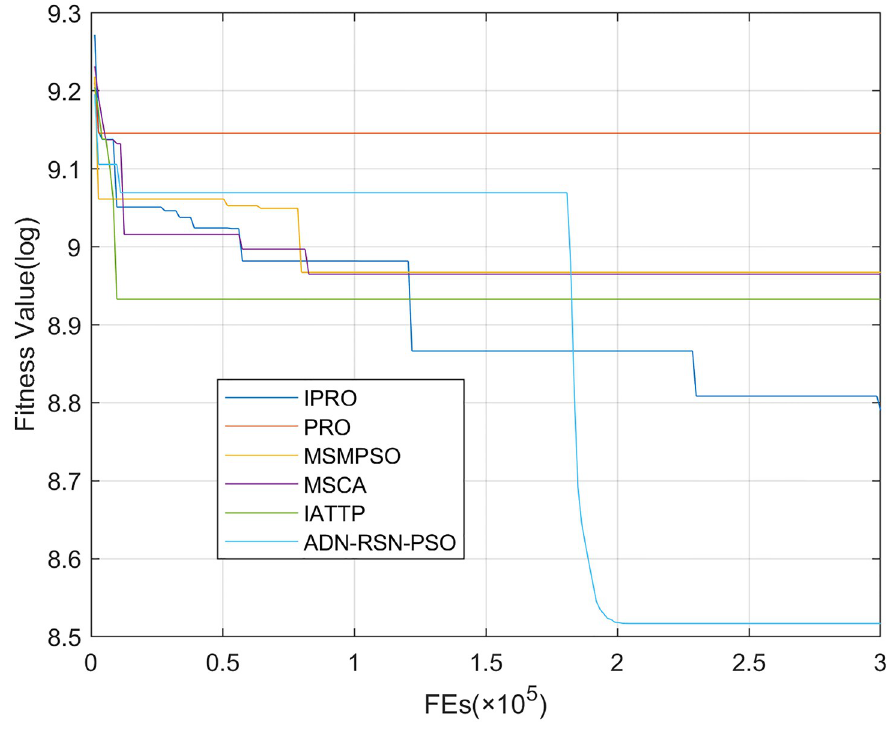
Fig 23. Convergence curves on F23.